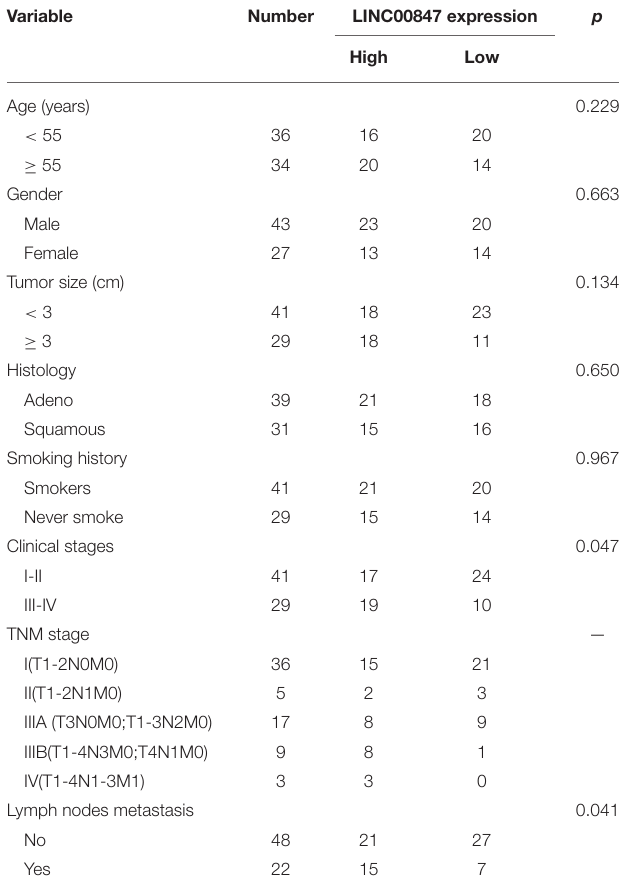
TABLE 2 | Correlation between LINC00847 expression and clinicopathological characteristics of NSCLC patients.